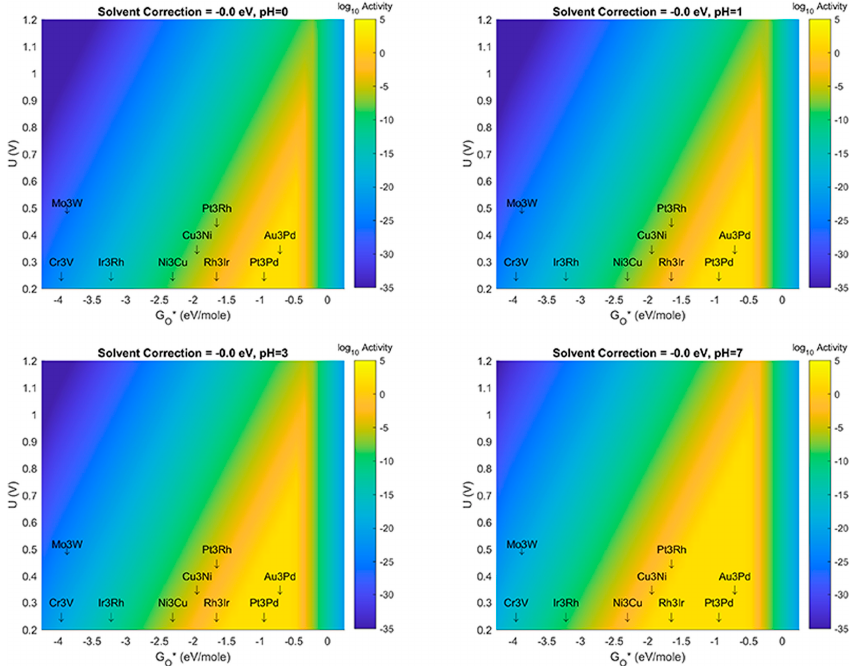
Figure 8. Volcano Plot analysis for ORR activity at solvent correction value of –0.20 eV. Top left (pH = 0), Top right (pH = 1), Bottom left (pH = 3), Bottom Right (pH = 7). Blue denotes lowest activity, yellow denotes highest activity. All plots use same color-axis scale hence some saturation at maximum activity and minimum activity. Activity given in log10 scale to show more detail in plot. Metals 2019 , 9 , x FOR PEER REVIEW 10 of 14